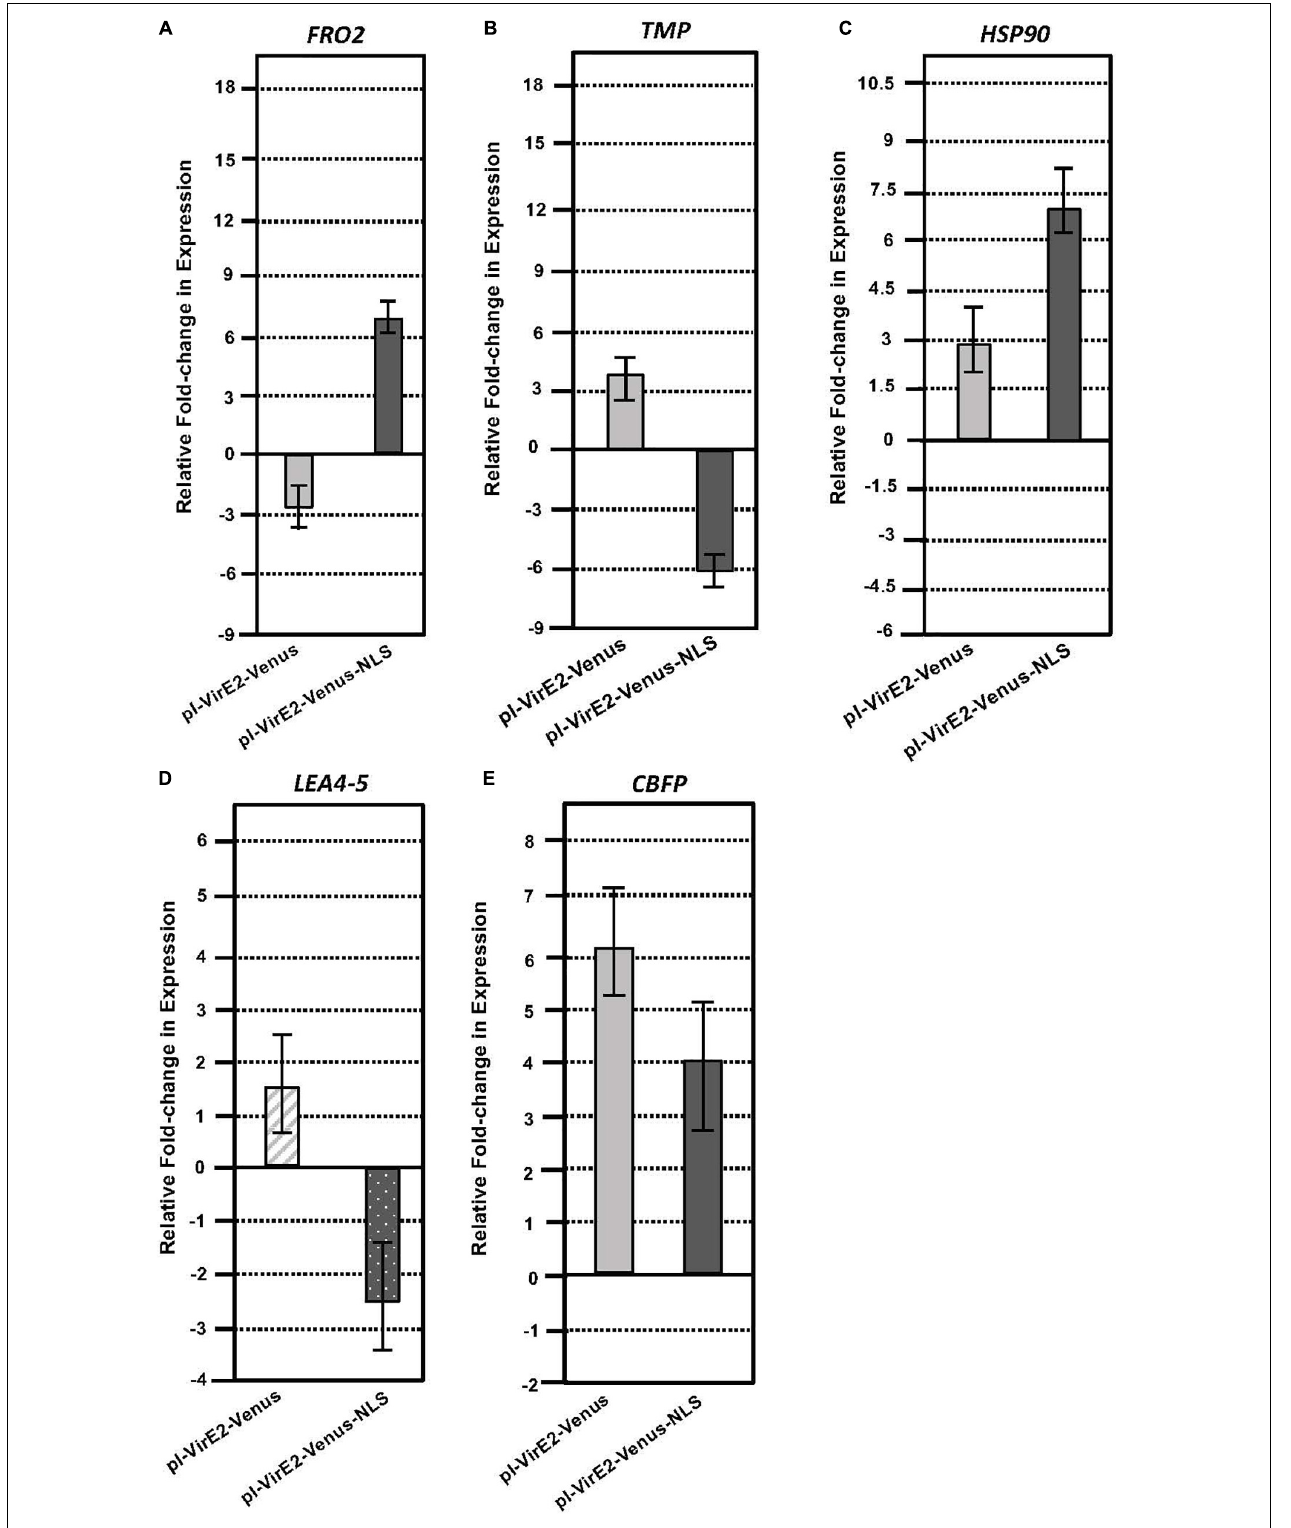
FIGURE 5 | Quantitative RT-PCR analysis of selected VirE2 differentially expressed genes in inducible VirE2-Venus (cytoplasmic) versus inducible VirE2-Venus-NLS (nuclear) plants. VirE2-Venus (left) and VirE2-Venus-NLS (right) results of (A) FRO2 , (B) TMP , (C) HSP90 , (D) LEA4-5 , and (E) CBFP gene expression in induced relative to non-induced roots. Bars represent an average of three technical replicates ± SE for one representative biological replicate of one transgenic line. Relative expression is shown after 3 ( LEA4-5 only) or 12 h after induction in the presence of A. tumefaciens A136.